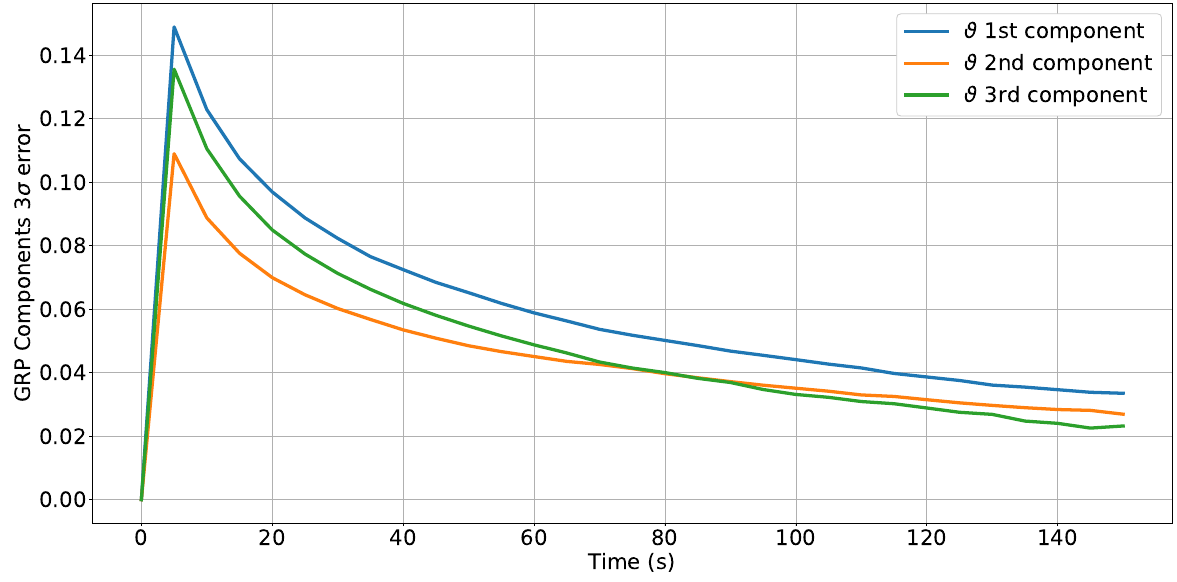
Figure 11. Estimated state vector error for the angles